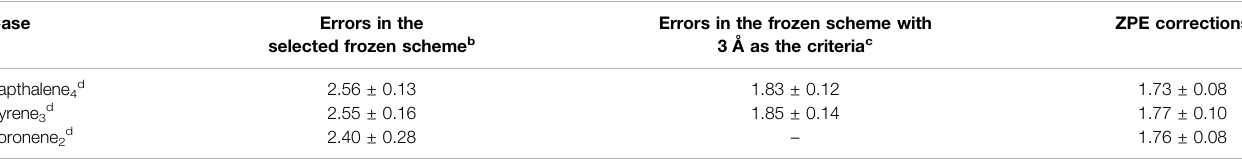
ZPE corrections